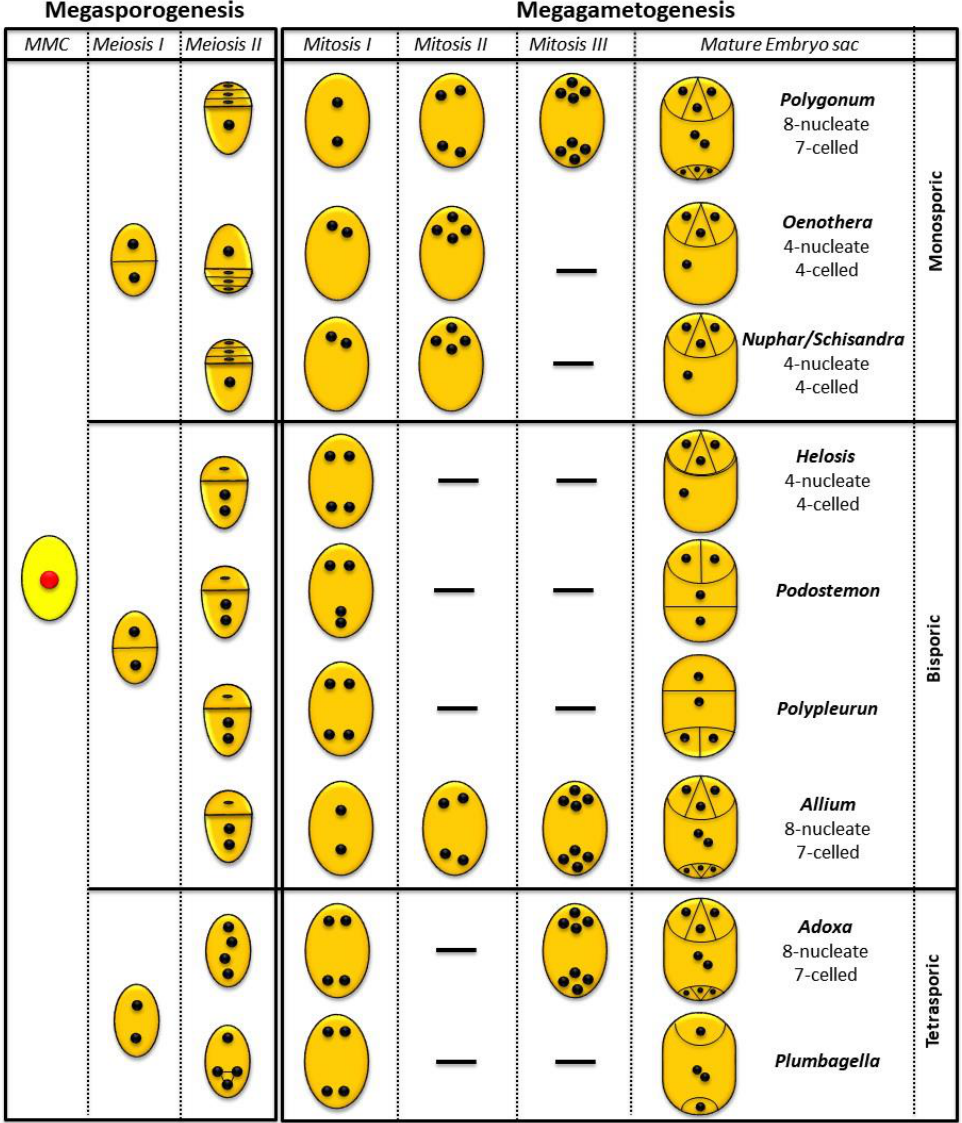
Figure 6. Comparative diagrams illustrating patterns of female gametophyte development between Helosis and others types of ES (based on Maheshwari [72], Tobe et al. [65] Johri et al. [6] and Sato & Gonzalez [15]).